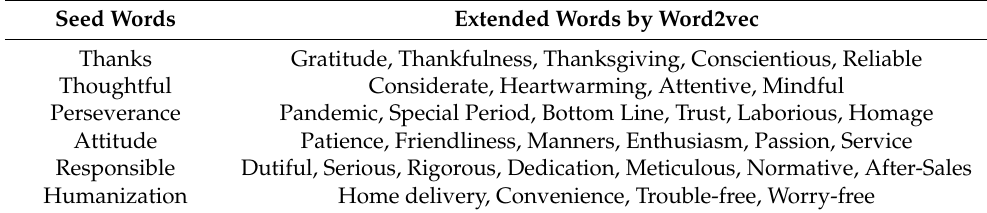
Table 3. Sentiment lexicon of “e-commerce temperature”.